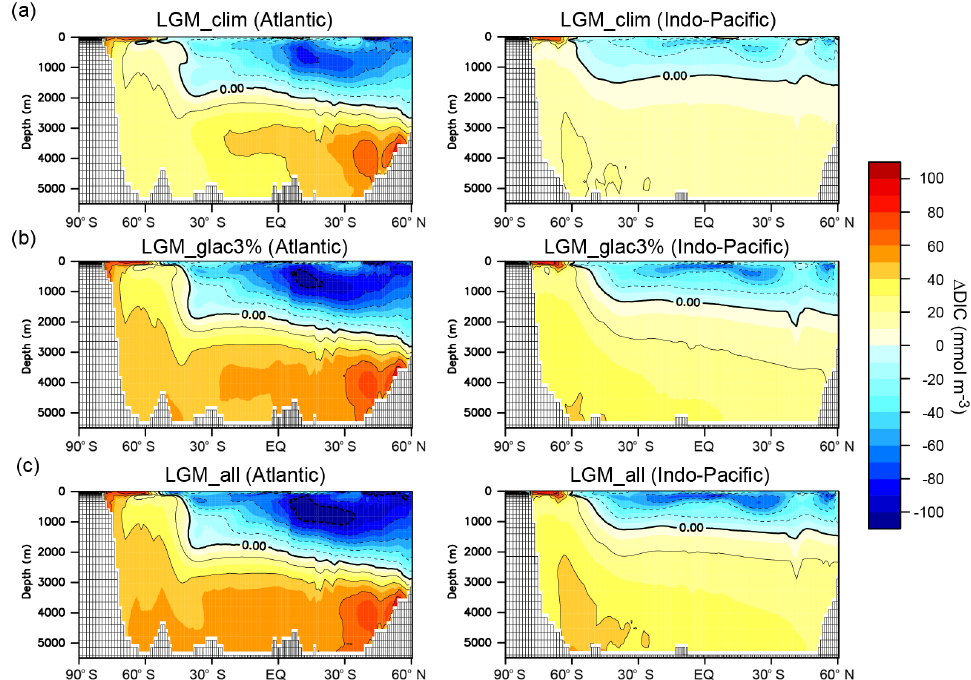
Figure 4. DIC change resulting from changes in the climate and biological pump in LGM simulations. Zonal mean changes in DIC from PI to (a) LGM_clim, (b) LGM_glac3%, and (c) LGM_all. The left and right panels show the Atlantic and Indo-Pacific oceans,